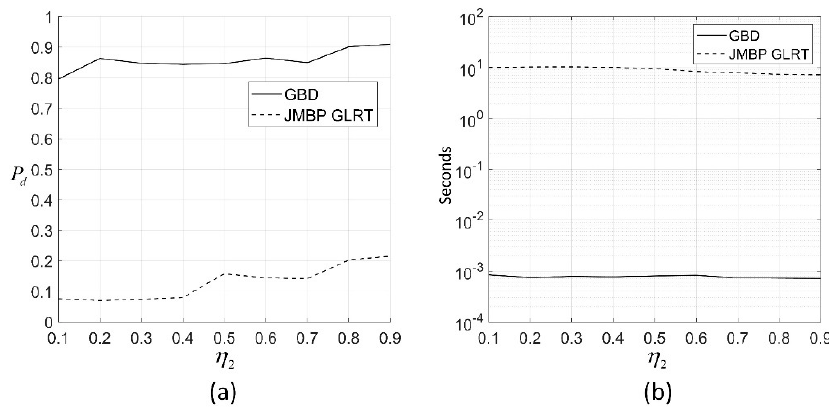
Figure 5. ( a ) P d of the two algorithms for different η 2 , with the Gaussian component 1 of the fourth Figure 5. ( a ) 𝑃 (cid:3031) of the two algorithms for different 𝜂 (cid:2870) , with the Gaussian component 1 of the fourth = 3.954, σ 1 = 0.3954, and the parameter set for scattering center of target 1 being µ 1 14 14 scattering center of target 1 being 𝜇 (cid:2869)(cid:2872)(cid:2869) (cid:3404) 3.954, 𝜎 (cid:2869)(cid:2872)(cid:2869) (cid:3404) 0.3954 , and the parameter set for component 2 being 𝜇 (cid:2869)(cid:2872)(cid:2870) (cid:3404) 7.908, 𝜎 (cid:2869)(cid:2872)(cid:2870) (cid:3404) 0.3954 . The range and angle parameters are 𝑐 (cid:2869)(cid:2872) (cid:3404) 0.3 , 𝜂 (cid:2869) (cid:3404) 0 , the parameter set for Gaussian components of target 2 is the same as target 1, and 𝑐 (cid:2870) (cid:3404) 0.6 , 𝜂 (cid:2870) sweeps